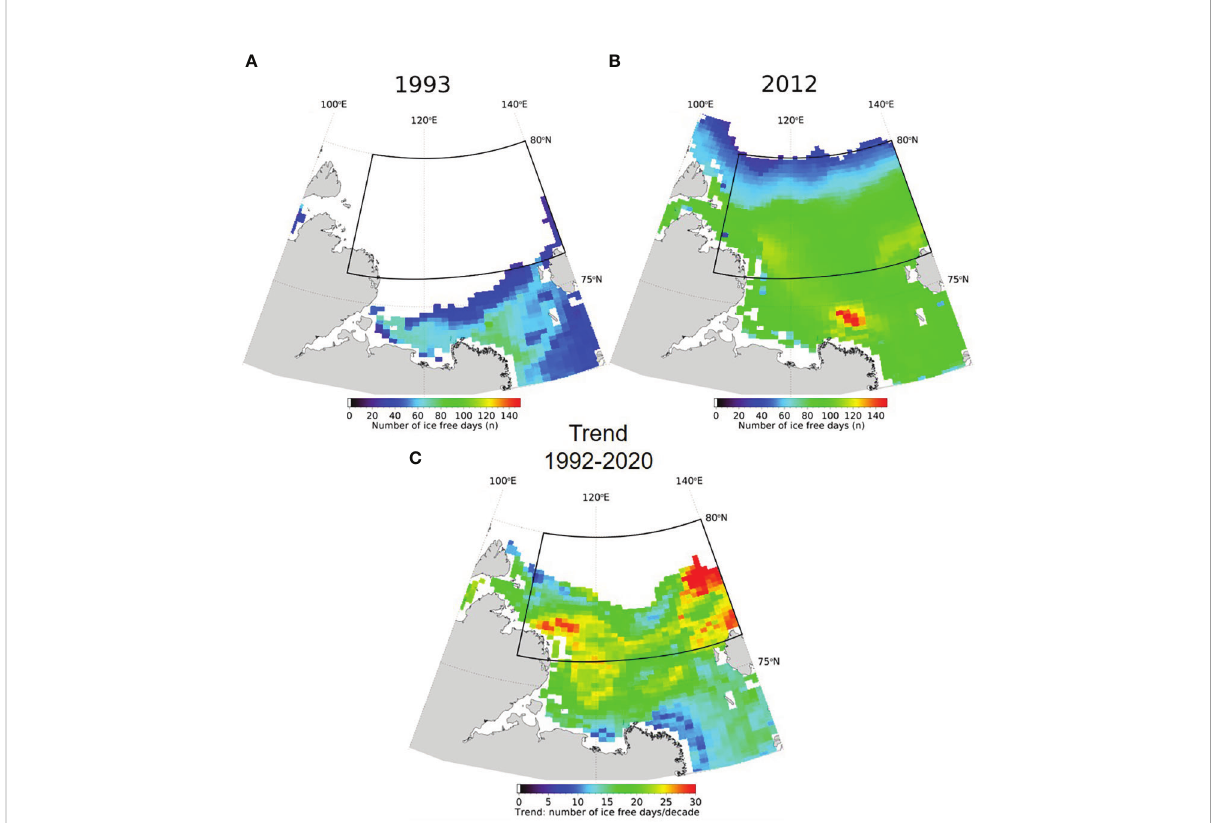
FIGURE 2 Number of ice free days in 1993 (A) and 2012 (B) ; white represents fully ice-covered, i.e. no ice-free days. (C) Trend (days/decade) in number of ice free days per year calculated based on remote sensing data from 1992 – 2020, based on 85GHz SSM/I brightness temperatures provided by CERSAT (Center for Satellite Exploitation and Research). The black rectangles indicate the area of